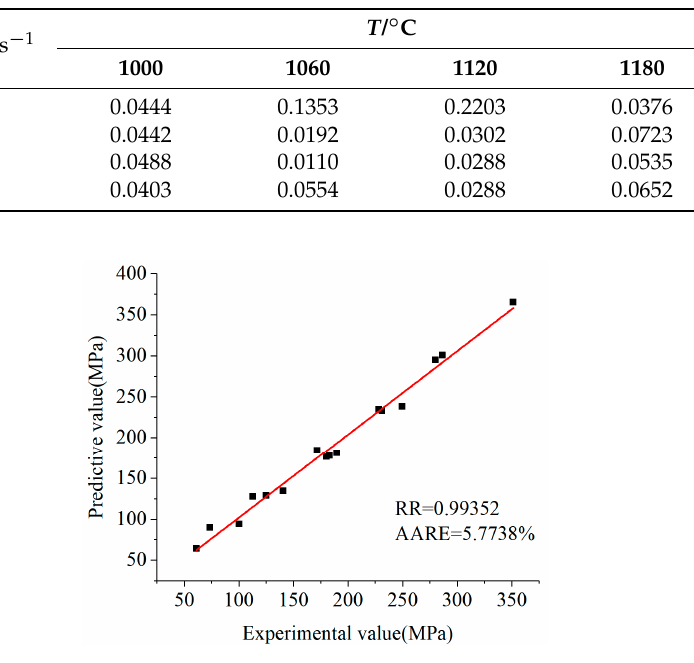
Table 4. The relative error ( ARRE ) between theoretical and corrected experimental.